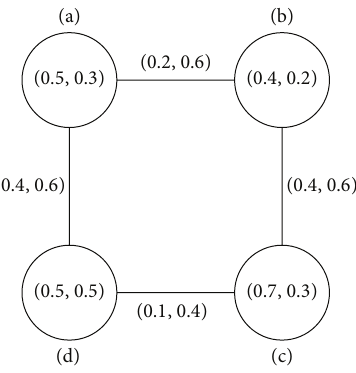
Figure 7: 𝐺 is regular and totally regular.